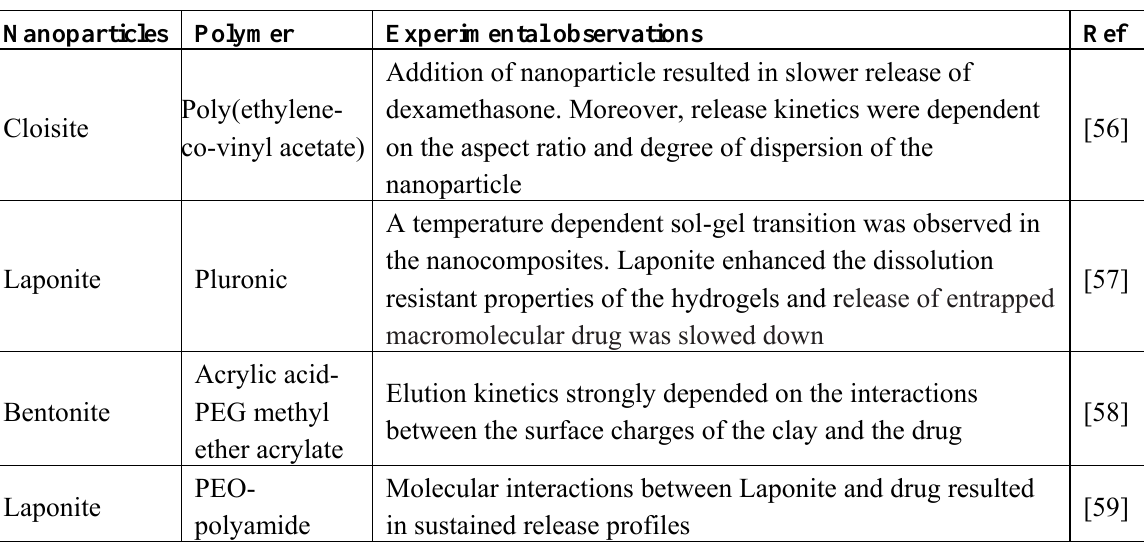
Table 3. Polymer layered silicate nanocomposite developments for drug delivery